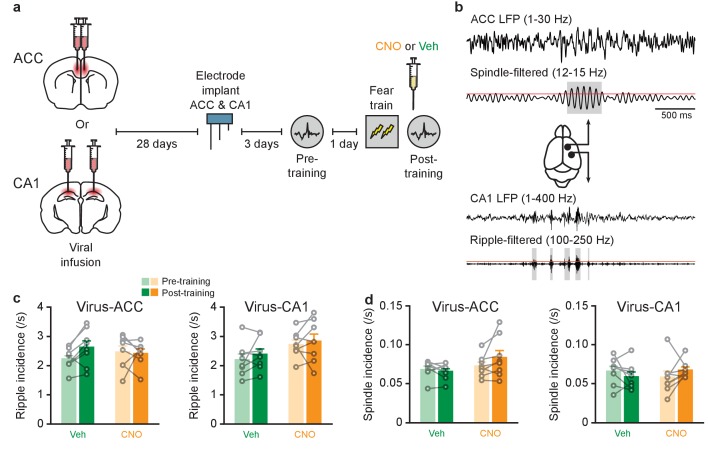
Inhibition of PV+cell in ACC or CA1 does not alter ripple or spindle incidence.(a) Experimental design. (b) Example traces of LFPs recorded in ACC (top two traces, low-pass filtered, and spindle-band filtered) and CA1 (bottom two traces, low-pass filtered, and ripple-band filtered), during a typical sleep session in one animal. Grey regions indicate spindles (top) and ripples (bottom) detected in ACC and CA1 LFPs, respectively. Red lines denote amplitude threshold used. Grey boxes denote ripple or spindle windows that passed detection threshold. (c,d) No change (c) in ripple incidence in mice micro-infused with virus in ACC (n = 8 per group; two-way repeated measures ANOVA pre-training versus post-training x Vehicle (Veh) versus CNO; pre-training versus post-training F1,14 = 1.77, p=0.20; Veh versus CNO F1,14 = 0.0007, p=0.98; interaction F1,14 = 2.91, p=0.11) or CA1 (n = 8 per group; pre-training versus post-training F1,14 = 1.317, p=0.27; Veh versus CNO F1,14 = 3.63, p=0.077; interaction F1,14 = 0.10, p=0.76), or (d) spindle incidence in mice miroinfused with virus in ACC (n = 8 per group; pre-training versus post-training F1,14 = 1.48, p=0.24; Veh versus CNO F1,14 = 2.25, p=0.16; interaction F1,14 = 3.54, p=0.081) or CA1 (n = 8 per group; pre-training versus post-training F1,14 = 0.039, p=0.85; Veh versus CNO F1,14 = 0.002, p=0.96; interaction F1,14 = 2.74, p=0.12). Data are individual mouse, or mean ±s.e.m.